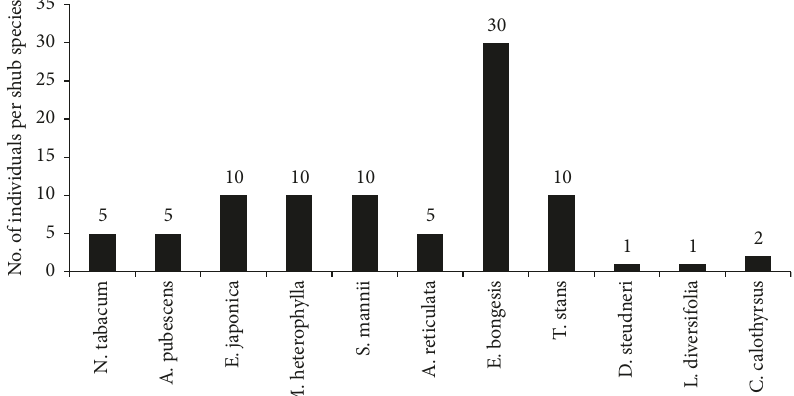
Figure 3: Number of individual shrub species identified in the self-regenerated secondary forest in Ruhande Arboretum, Huye,